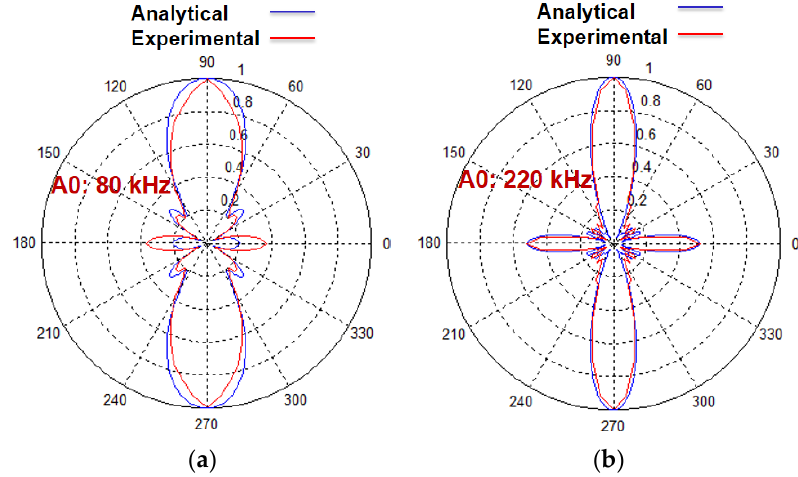
Figure 9. Comparison of directivity patterns of the A0 mode of P1-type MFC transducer with a modified analytical model at 80 kHz ( a ) and 220 kHz ( b ) and experimental analysis.